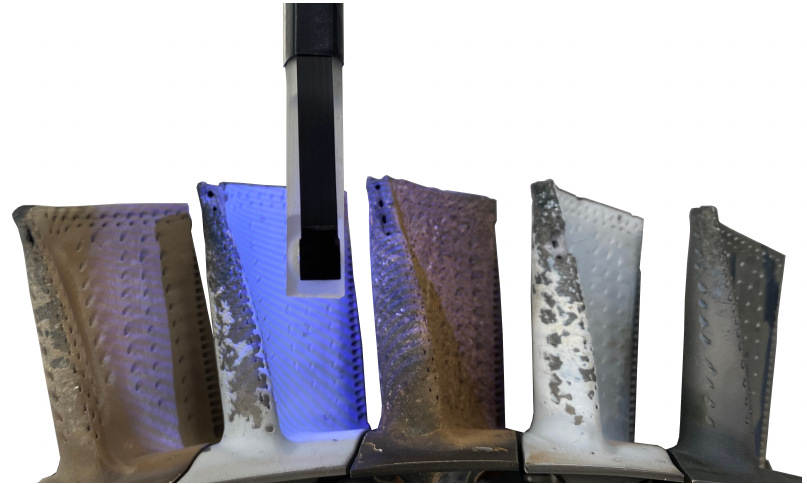
Figure 4. Borescopic Inspection of turbine blades using a 8mm sensor head.